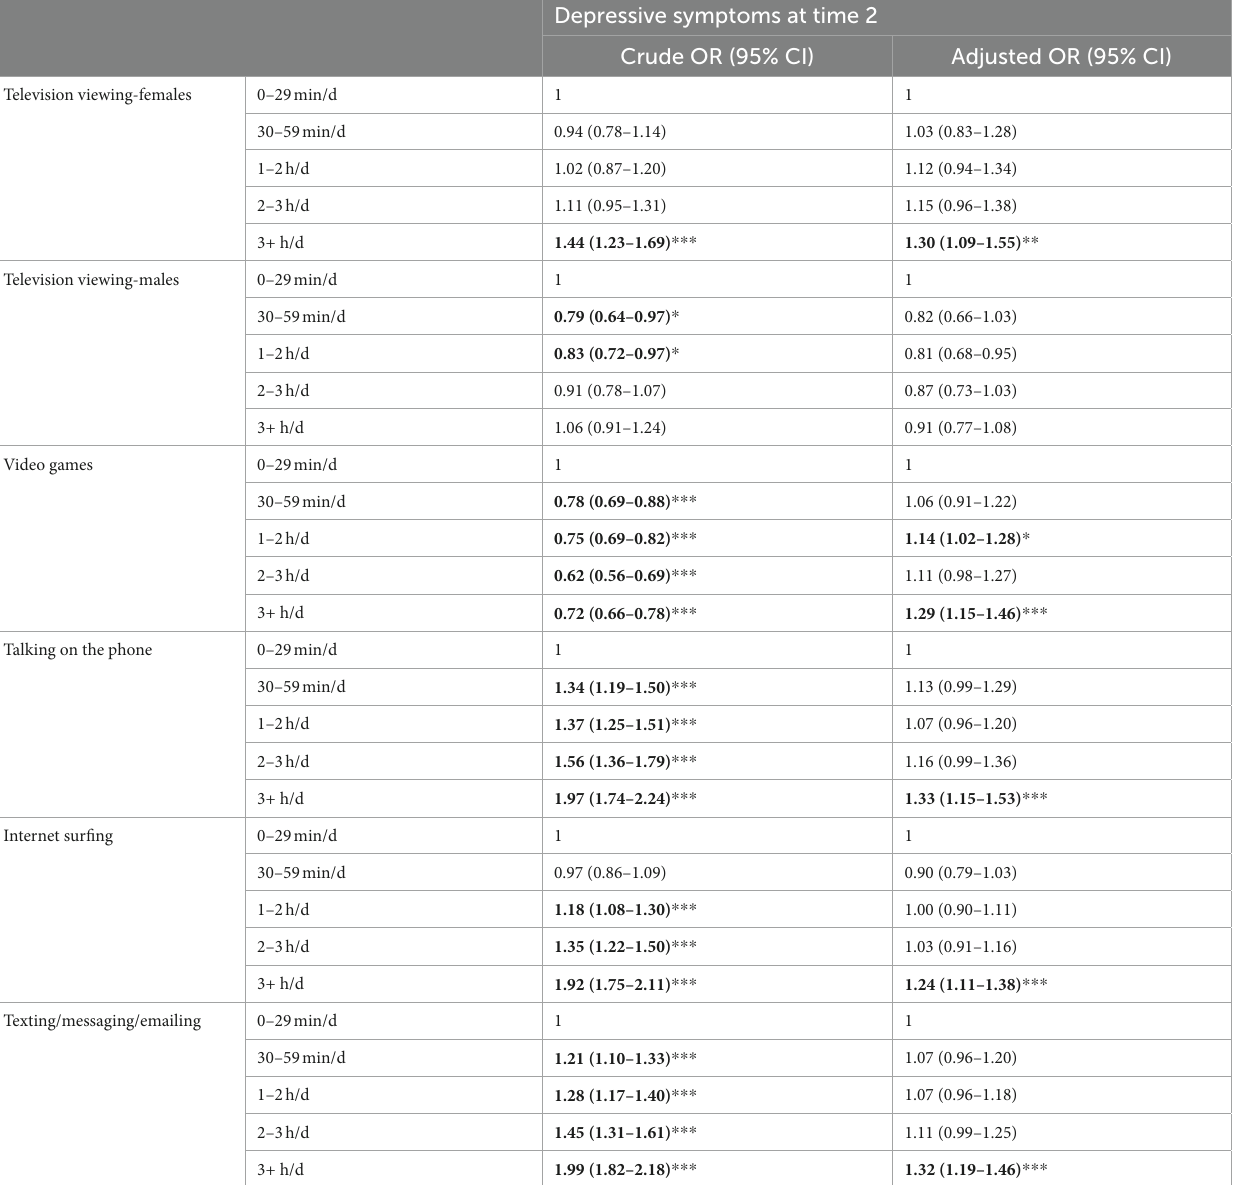
Bold values represent statistically significant results. OR, odds ratio; CI, confidence interval. Models are adjusted for school clustering, age, race/ethnicity, BMI z -score, income, and prior year depression. * p < 0.05; ** p < 0.01; *** p <